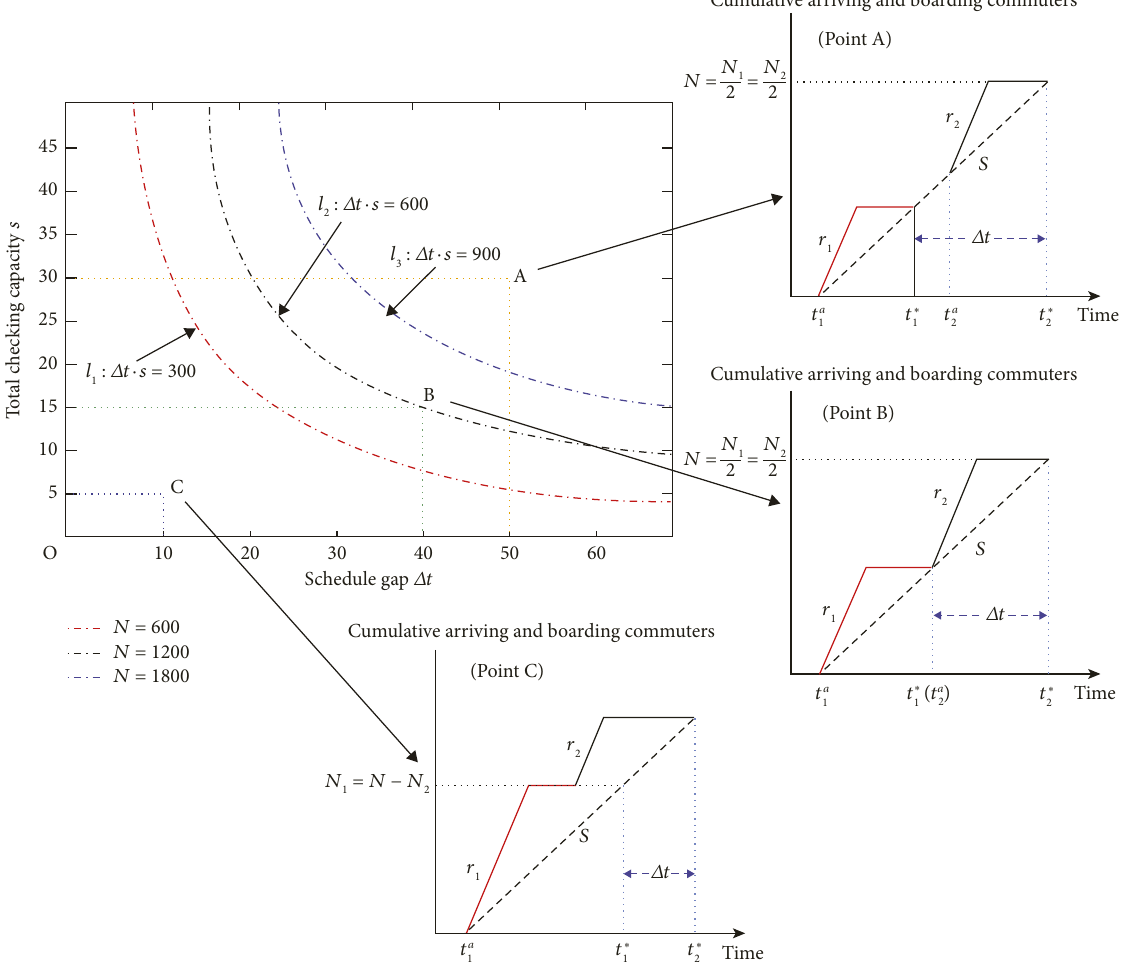
Figure 4: Decision space for PT shuttle choice among staggered